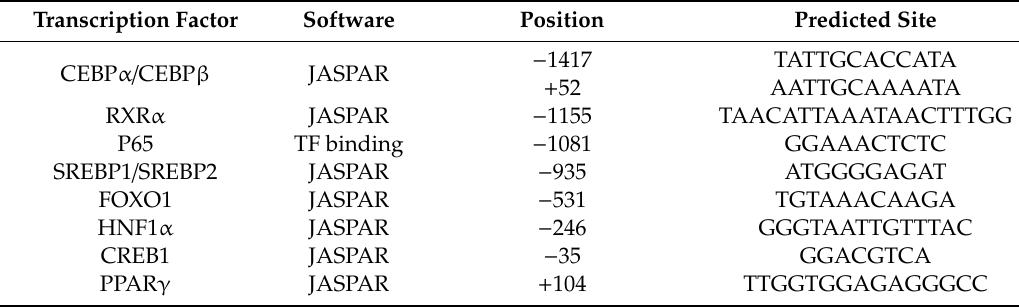
Table 2. The transcription factor binding sites predicted by software online.